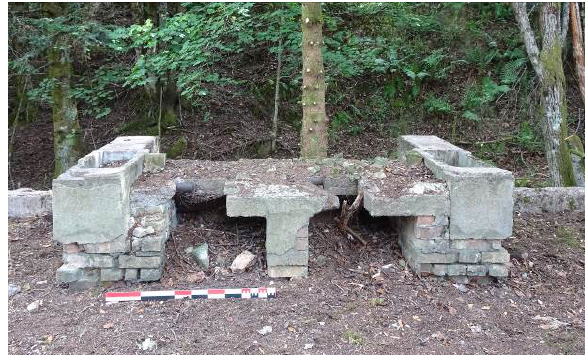
Figure 6 : Forge fireplace.